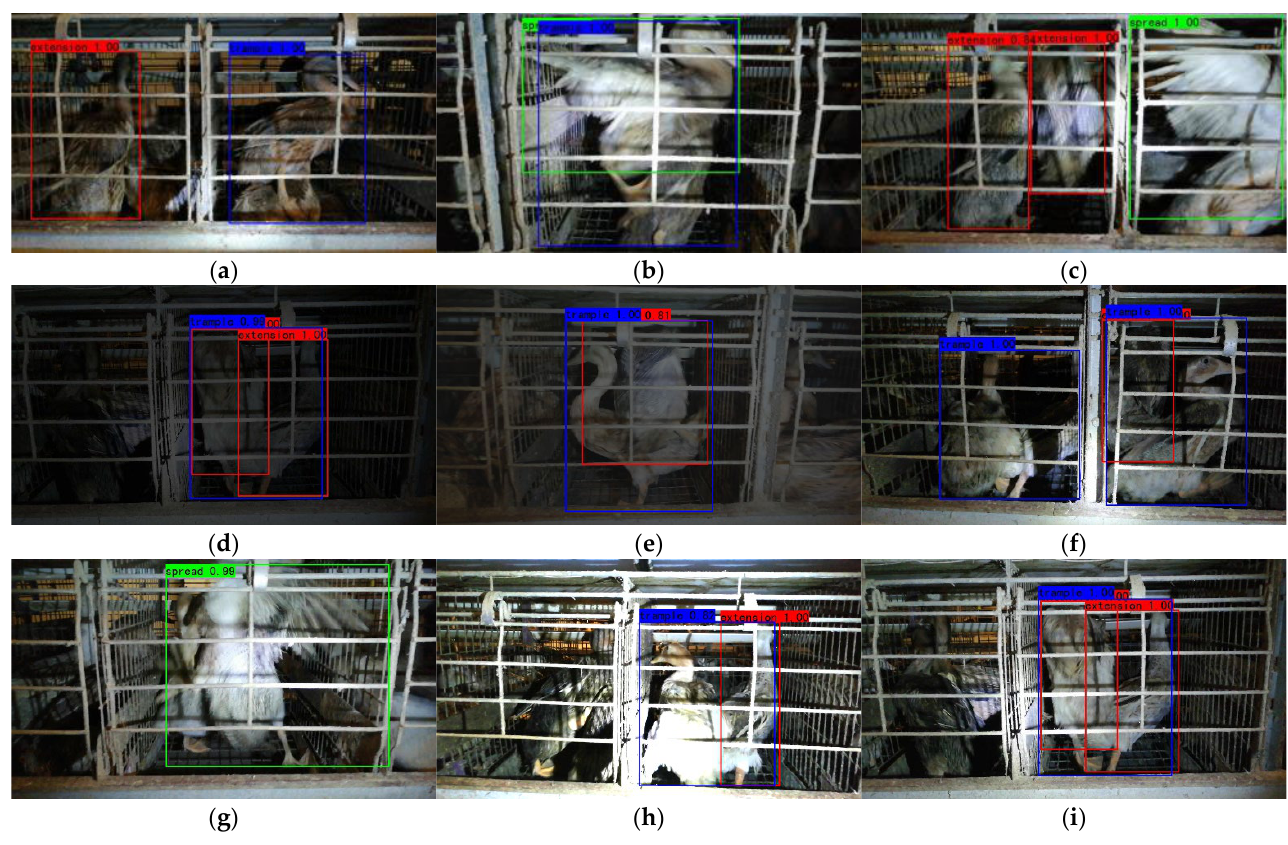
Figure 11. Behavior detection results of cage-reared ducks. ( a – c ) test results under normal light source, ( d – f ) test results in dark environment, ( g – i ) test results in bright environment.